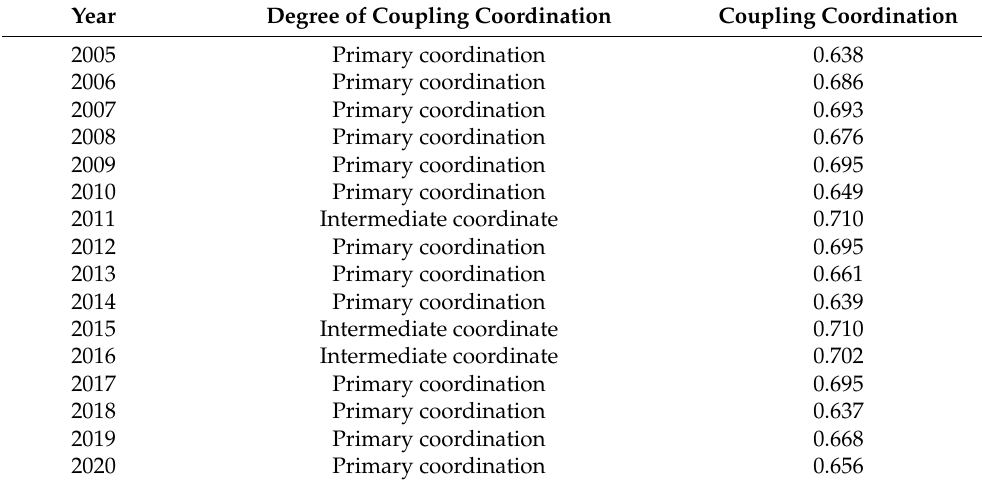
Table 6. Mean value of coupling coordination degree in Tarim River Basin from 2005 to